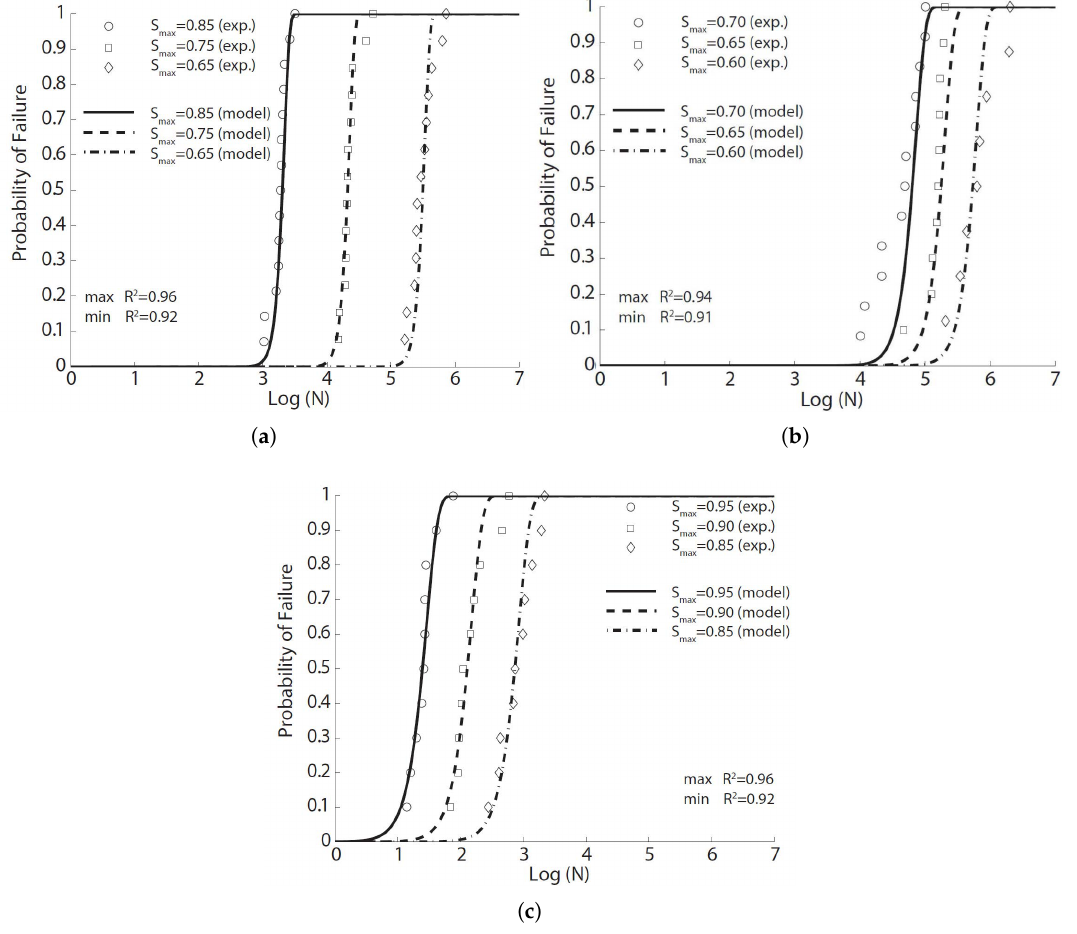
Figure 1. Comparison of the flexural fatigue data for concrete by ( a ) Oh [29], ( b ) Shi et al. [15] and ( c ) Zhang et al. [35], where R 2 is Pearson’s correlation